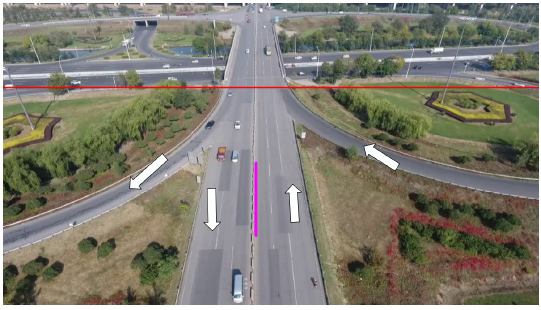
Figure 8. Vehicle-counting area and direction. Below the red line is the detection area, in which the right side of the pink line is the forward direction, and the left side is the backward direction.